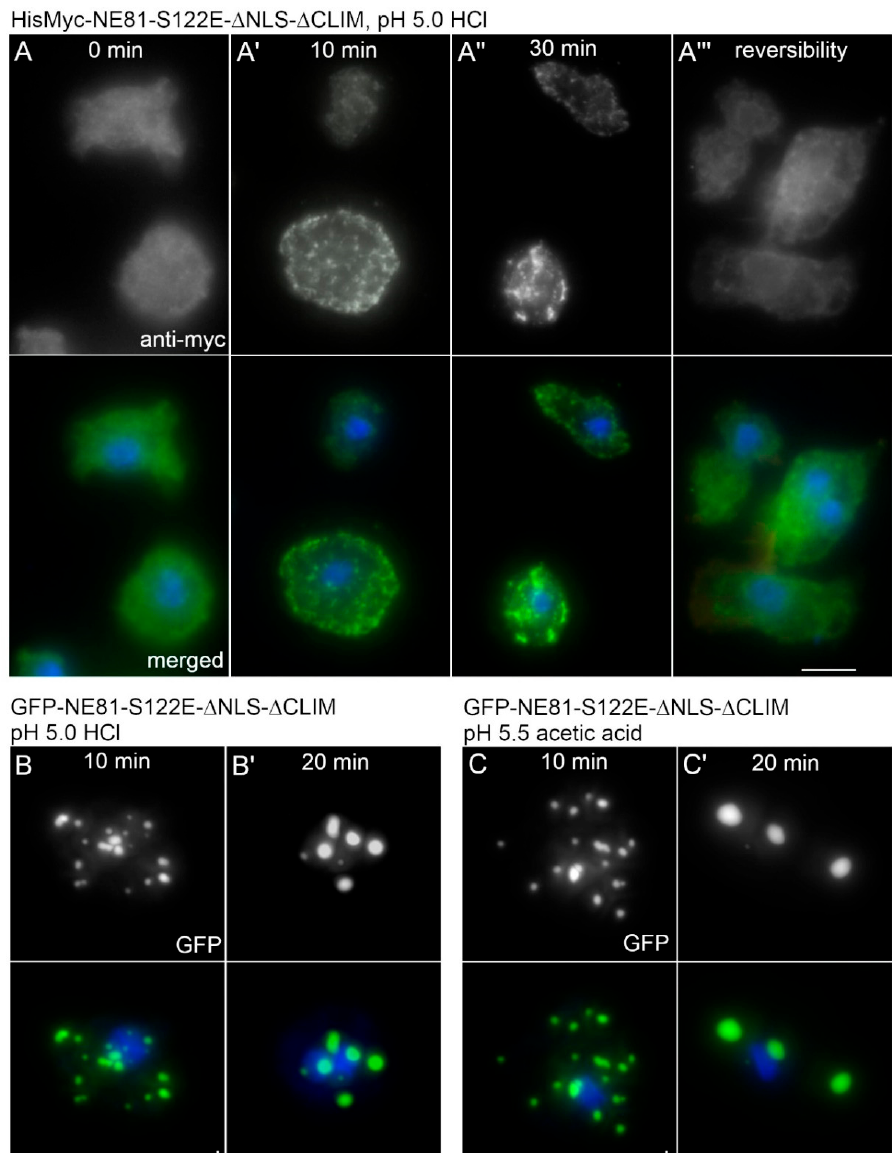
Figure 6. NE81-S122E Δ NLS Δ CLIM forms reversible cytosolic protein clusters at low pH. ( A – A’’’ ) Fluorescence microscopy of fixed HisMyc-NE81-S122E Δ NLS Δ CLIM cells stained with DAPI and anti-Myc/anti-mouse-AlexaFluor 488. Merged images show NE81-S122E Δ NLS Δ CLIM in green and chromatin in blue: ( A ) control cells in HL5c medium (pH 6.5), t = 0 min; (and A’ , A’’ ) cells incubated in HL5c medium acidified to pH 5.0 with HCl for 10 min ( A’ ) and for 30 min ( A’’ ). ( A’’’ ) Cells shifted back from pH 5.5 to HL5c medium at pH 6.5 for 45 min to show the reversibility of the process. ( B , C ) Fluorescence microscopy of fixed GFP-NE81-S122E Δ NLS Δ CLIM cells stained with DAPI. Merged images show NE81-S122E Δ NLS Δ CLIM in green and chromatin in blue. ( B ) Cells were incubated in HL5c medium acidified to pH 5.0 with HCl for the indicated time periods. ( C ) Cells were incubated in HL5c medium acidified to pH 5.5 with acetic acid for the indicated time period. Note that fusion protein clusters increase in size but decrease in numbers in ( B , C ), indicating the coalescence of GFP-NE81-S122E Δ NLS Δ CLIM assemblies with time. For ( B , C ), the respective control situation in HL5c medium (pH 6.5) is shown in Figures 1B, 2A,B and 4A,A’. Scale bars = 5 µm.